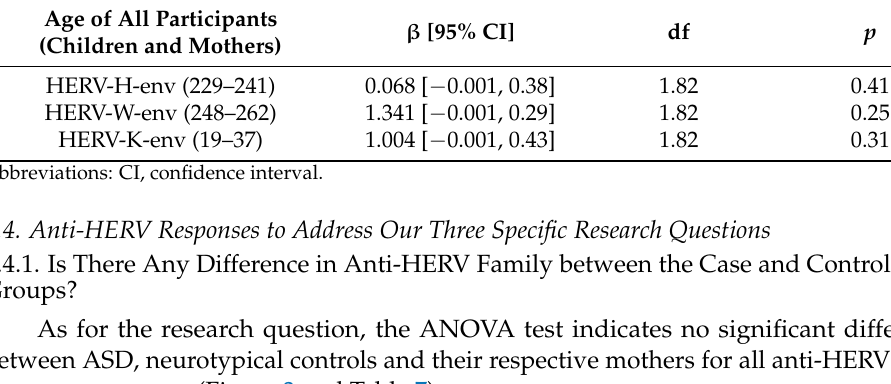
Table 6. Linear regression between all the ages and HERV levels.